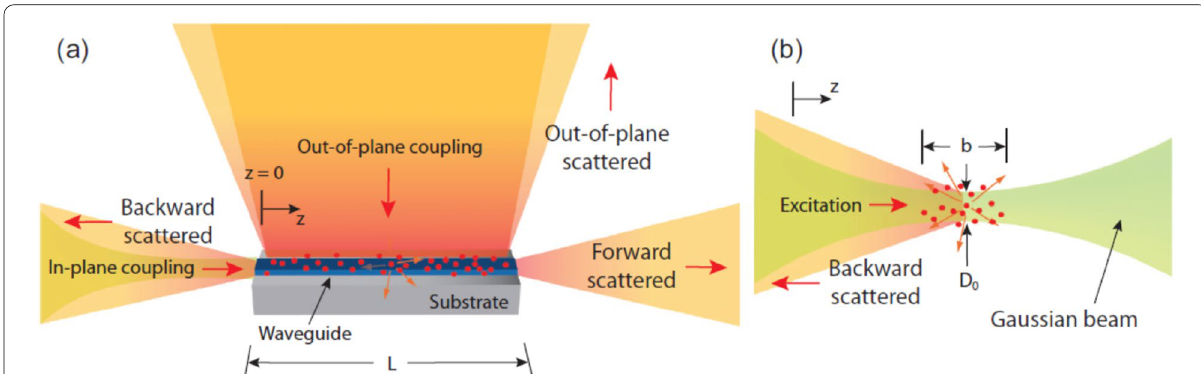
Fig. 1 a Schematic of different configurations of laser excitation and Raman scattered light collection with respect to the WG of length L oriented in the light guiding z direction. Excitation is either (i) in plane via coupling to the WG mode or (ii) out-of-plane from the top. Collection is either in the (I) forward, (II) backward, or (III) out-of-plane scattered direction. b Schematic of laser excitation and Raman scattered light collection in free space. Excitation is in the forward direction and Raman scattered light is collected in the backward direction. The Gaussian beam is propagating in the z direction with waist diameter D 0 and depth of focus b. (Reprinted with permission from Ref. [53])